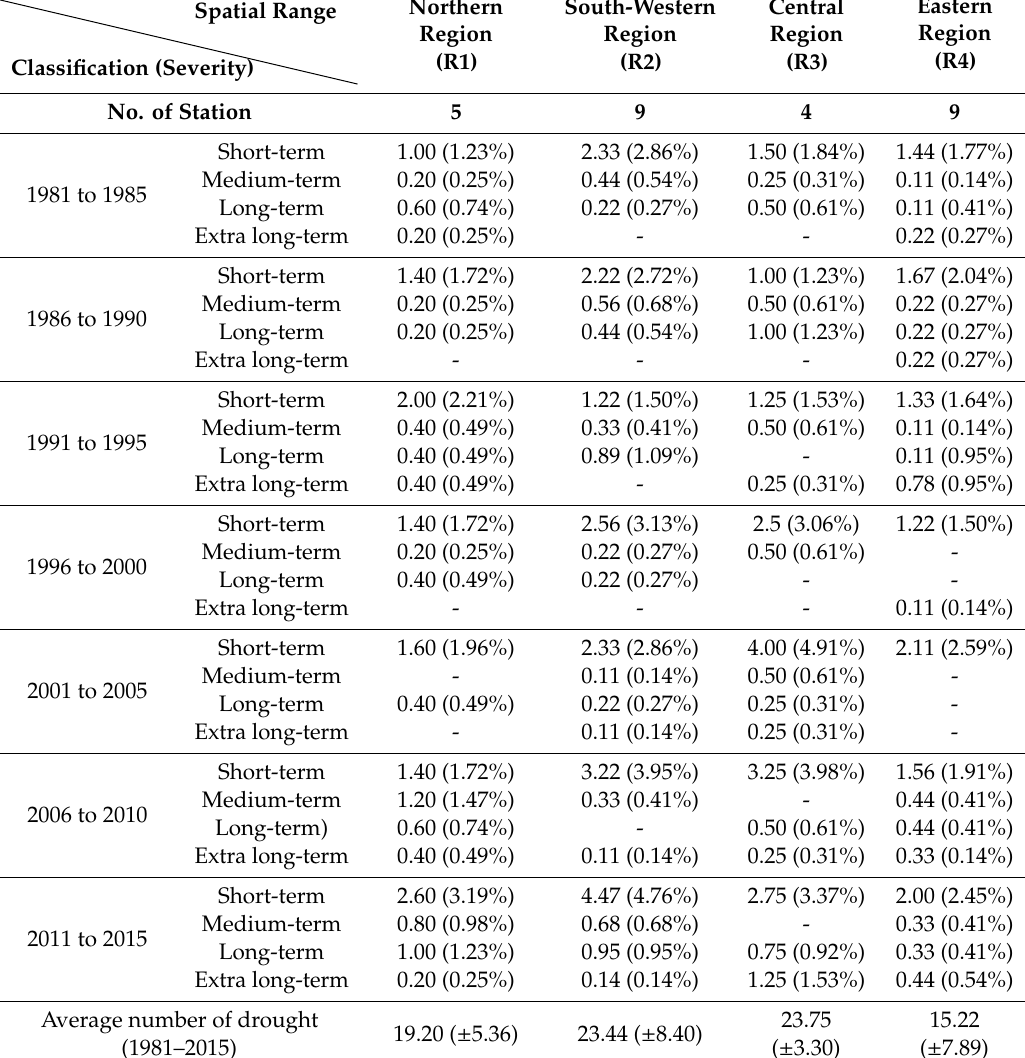
Table 6. Regional drought events by duration in seven quinquennial periods from 1981 to 2015.